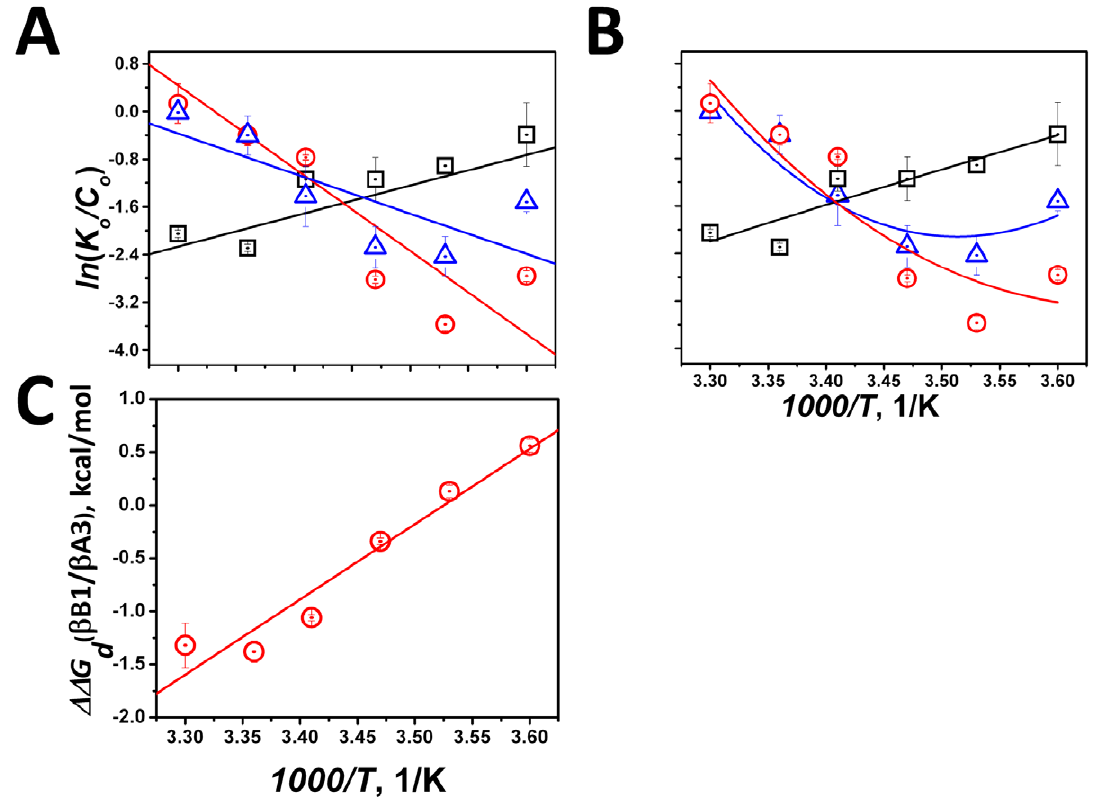
Figure 1. The temperature dependence of changes in the free energies for the dimeric association of b B1 and b A3 and the tetrameric association of b B1/ b A3. Asssociation of b B1, b A3 and b B/ b A3 are shown by blue open triangles, black open squares and red open circles, respectively. Panels A and B: van’t Hoff plots where ln(K d /C o ) is plotted as function of the reciprocal of absolute temperature ( 1000/T ), K d ’s are the dissociation constants obtained from analytical ultracentrifugation, and C o is the m M concentration. Panel A: the difference in heat capacity ( D C p ) is constrained to be 0, resulting in a linear function; Panel B: D C p is not constrained and has a nonzero value. Panel C: temperature dependence of Gibbs free energy gained in formation of b B1/ b A3. DD G d ( b B1/ b A3) is defined as a difference between Gibbs free energy changes of tetrameric b B1/ b A3 and that of individual components ( b B1 and b A3). Concentrations for b B1, b A3, and b B1/ b A3 crystallins were each 0.5 mg/ml.